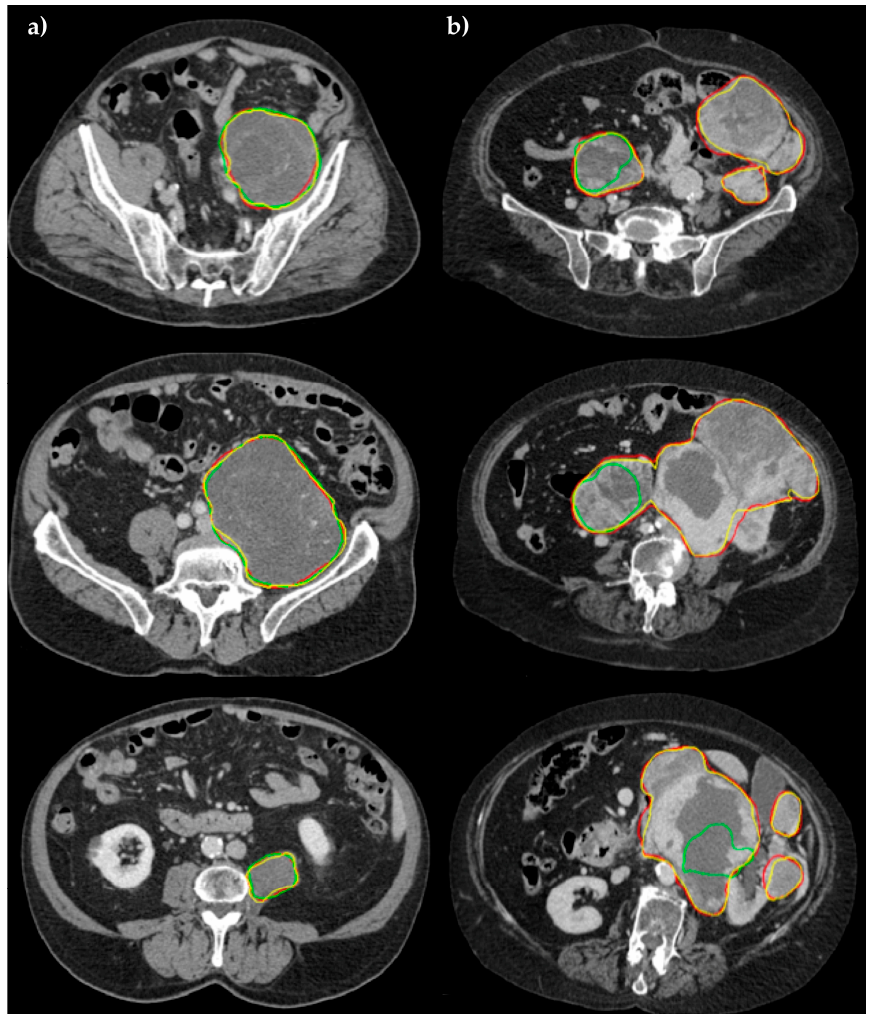
Figure 3. Comparison of segmentation performance in three different slices for ( a ) patient #005, and ( b ) patient #033. Manual (yellow), ENet (red), and ERFNet (green) segmentations are superimposed. In the first study, ENET and ERFNet obtained optimal DSCs (96.69% and 93%, respectively). In the second study, ERFNet showed poor DSC (30.55%) while ENET maintained similar performance compared to the first study (95%).